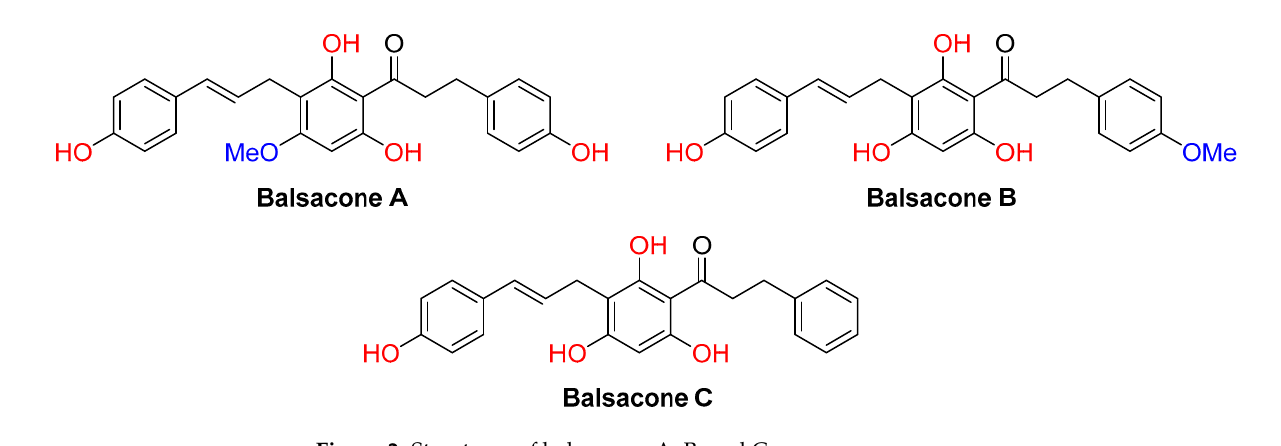
Figure 2. Structures of balsacones A, B, and C.